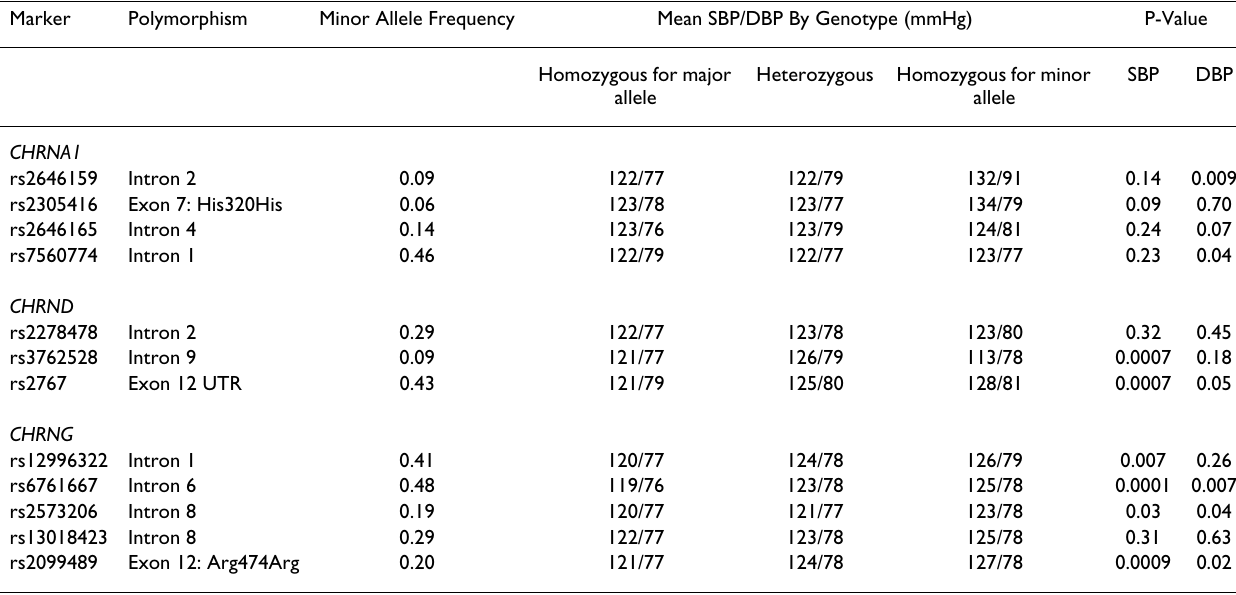
Table 2: Association analysis of polymorphisms in CHRNA1 , CHRND and CHRNG with blood pressure in the AFDS.